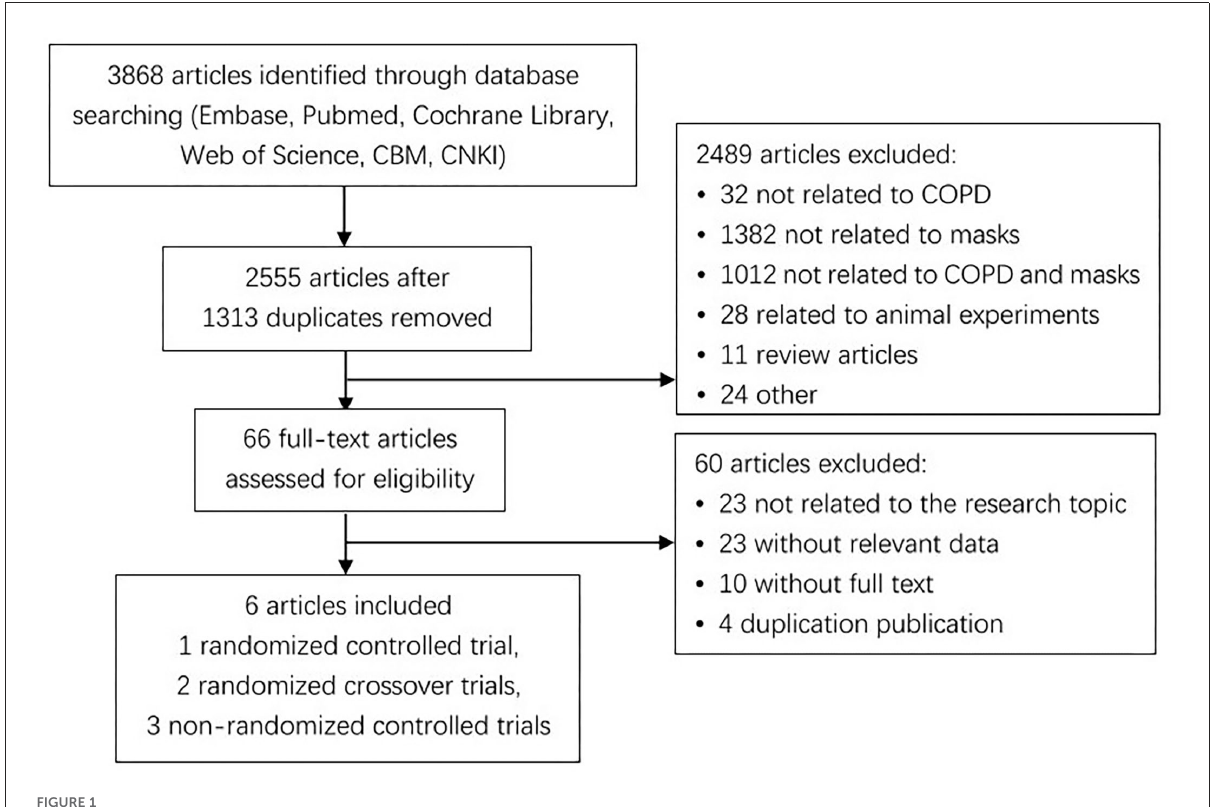
FIGURE1 STROBE diagram of the study’s selection